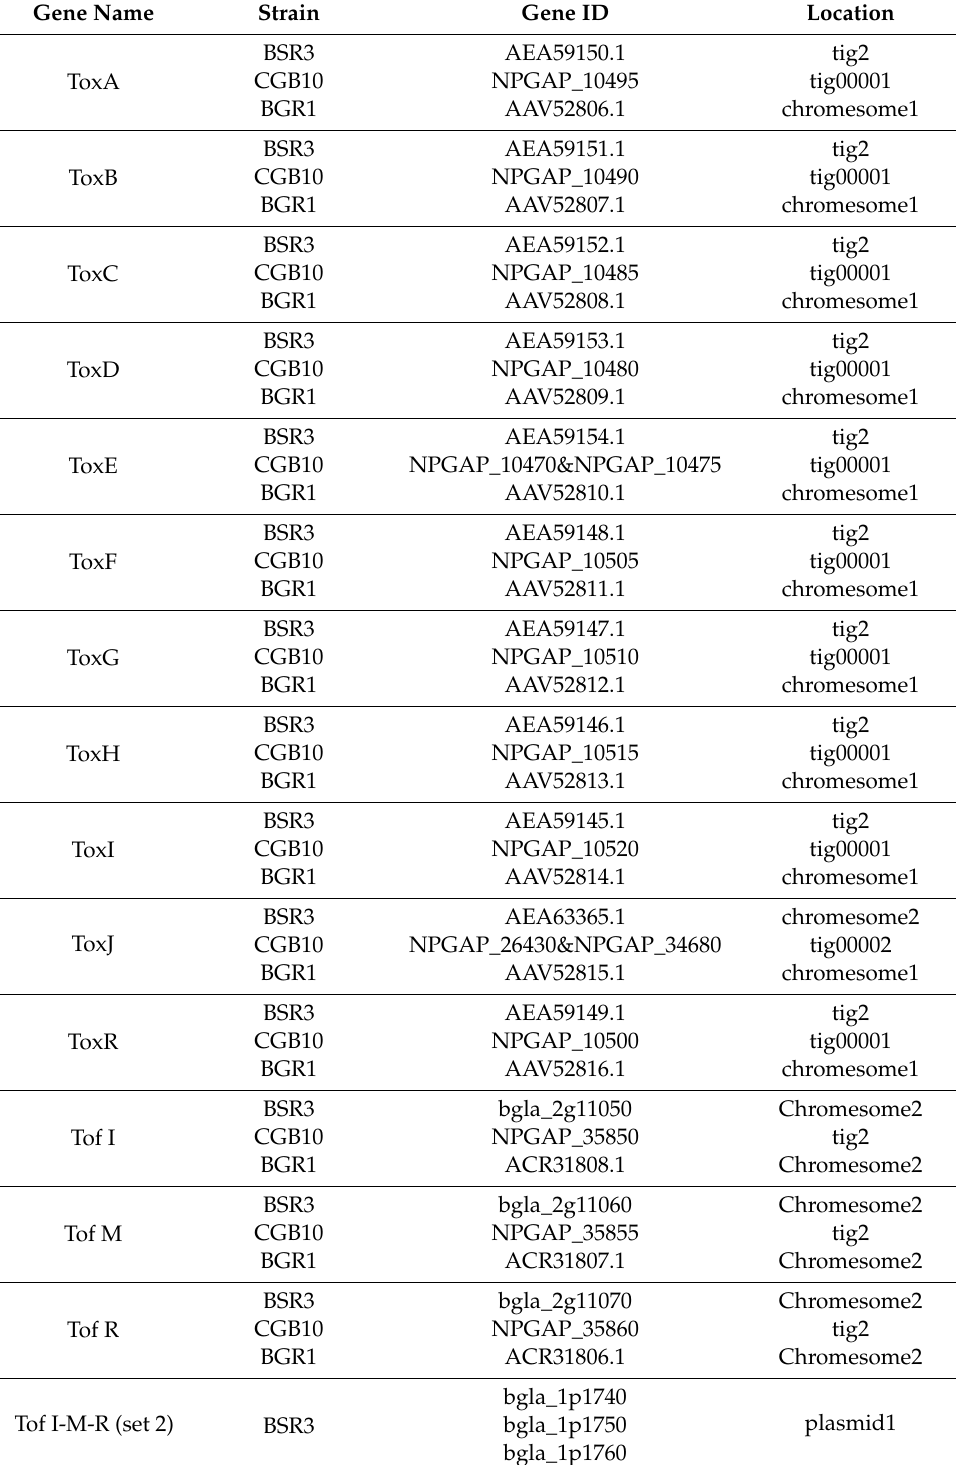
Table 3. Prediction of Tox and Tof gene